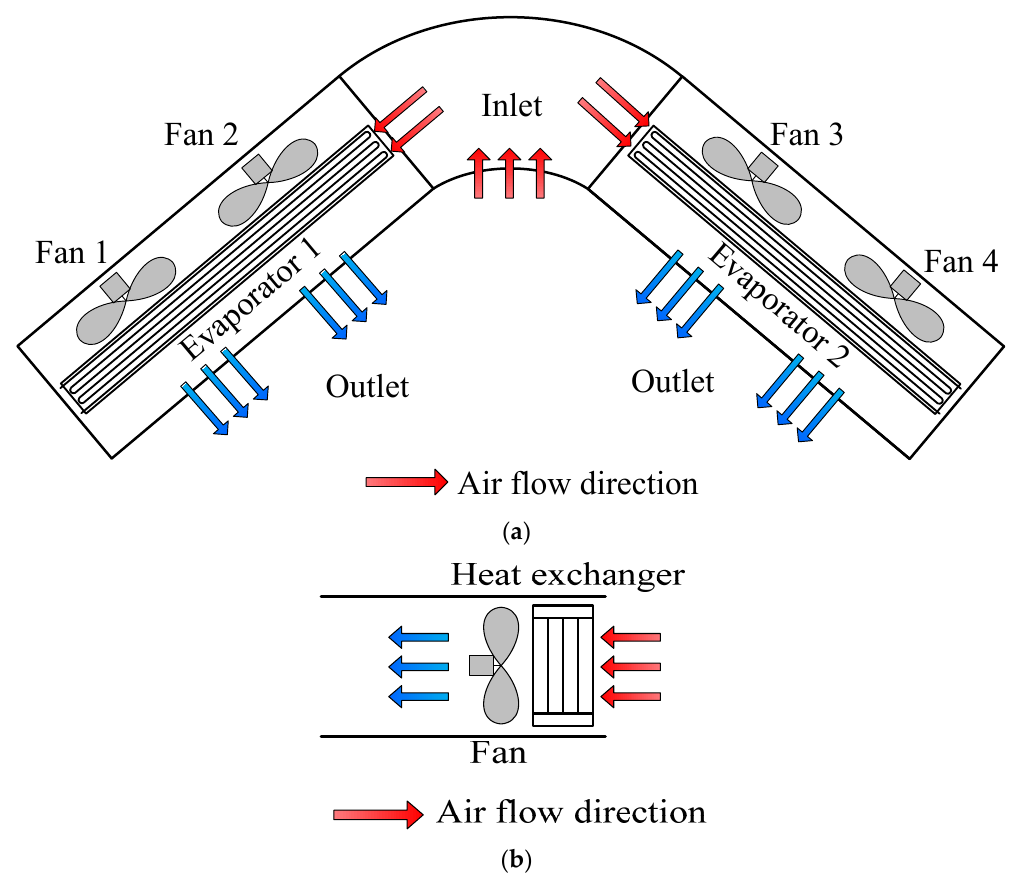
Figure 2. Schematic diagrams of the evaporator and condenser parts. ( a ) One section of the evaporator part; ( b ) Condenser part.